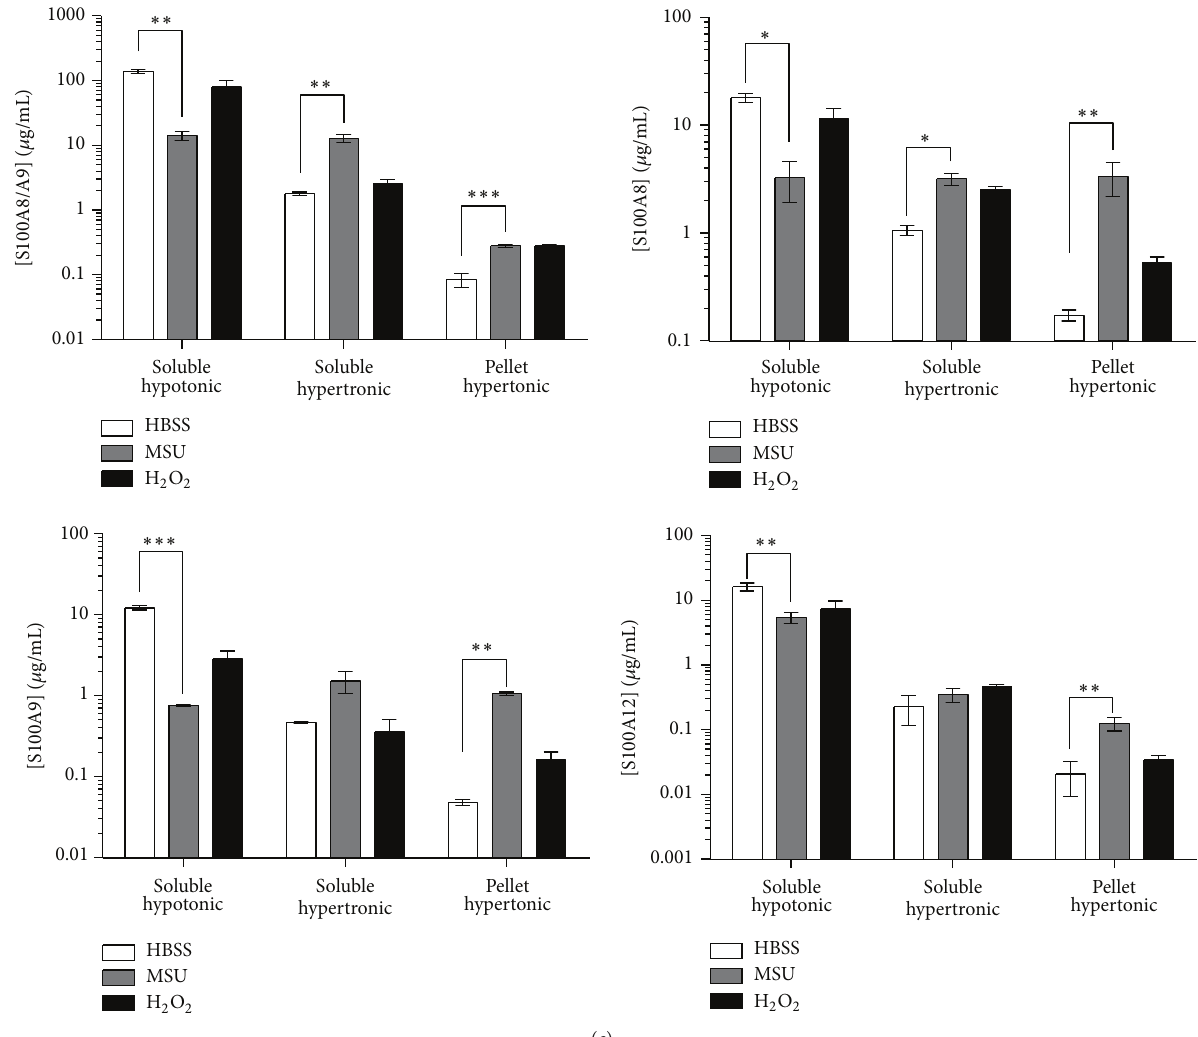
Figure 7: S100A8, S100A9, S100A12, and calprotectin move toward cytoskeleton/lipid raft fractions following neutrophils stimulation by H 2 O 2 or MSU. Neutrophils were stimulated with 1.5 mg/mL MSU crystals or 250 𝜇 M H 2 O 2 and supernatants harvested before sequential cells lysis as described in Section 2. Fractions were loaded onto SDS-PAGE and (a) 𝛽 actin, 𝛼 tubulin, and flotillin-1 or (b) S100A8/A9 or S100A12 was detected by immunoblotting. Results are from one experiment are representative of 2 others. (c) Fractions were subjected to sandwiches ELISA against S100A8, S100A9, S100A12, or S100A8/A9. Results represent the mean ± SEM of 4 donors quantified in duplicate. ∗ 𝑃 < 0.05 ; ∗∗ 𝑃 < 0.01 ; ∗∗∗ 𝑃 < 0.001 , MSU versus